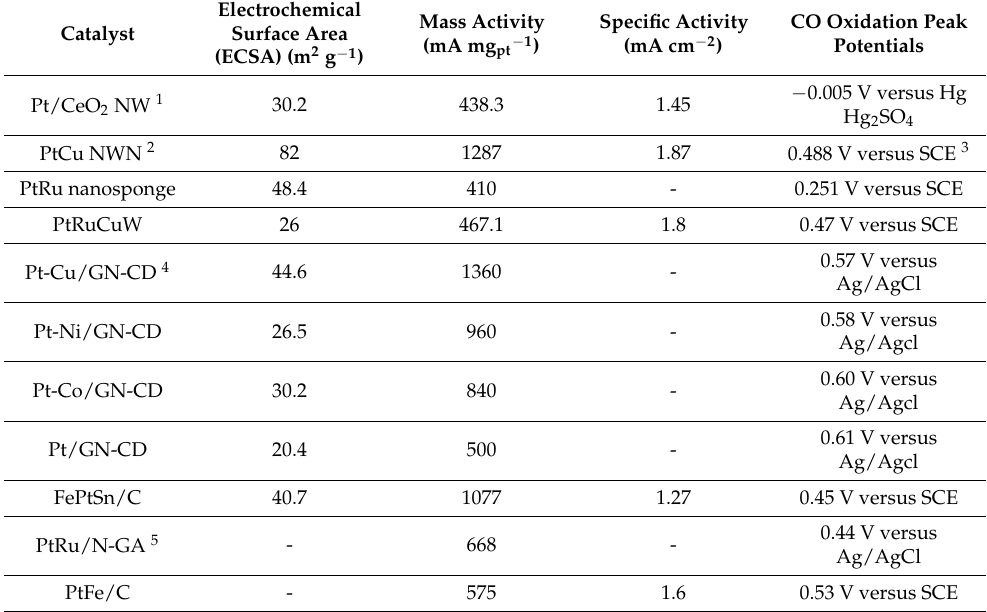
Table 2. Comparison of catalyst performance according to different studies